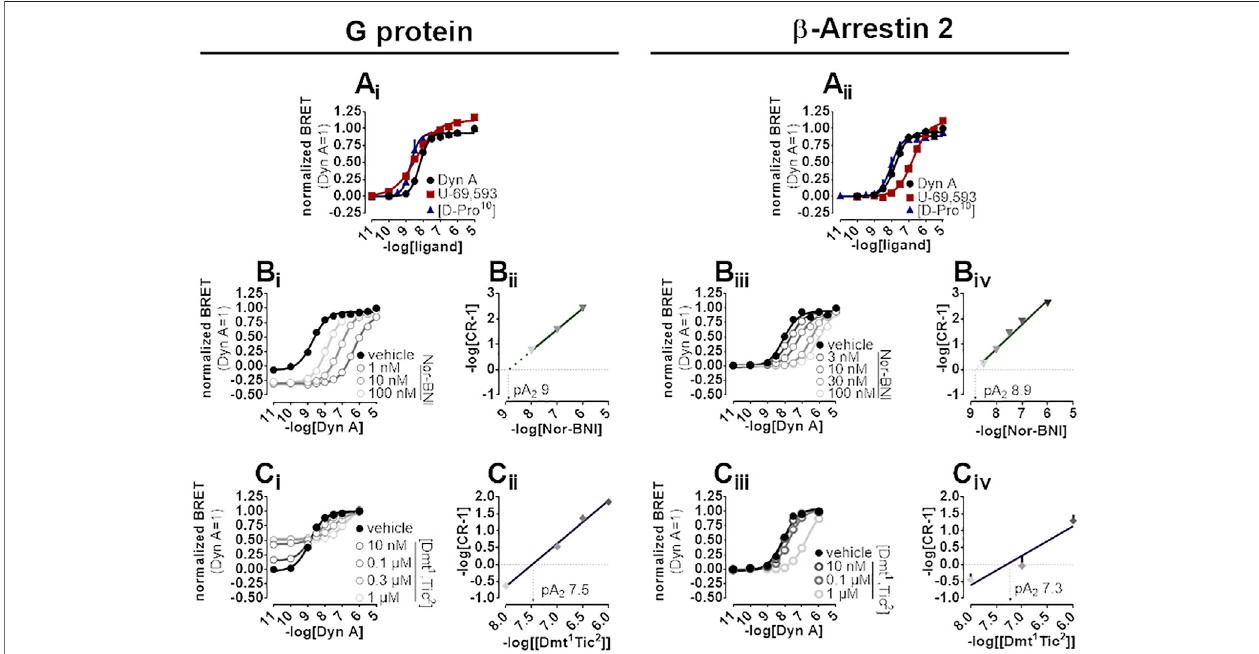
FIGURE 4 | BRET experiments in SH-SY5Y cells stably expressing the human kappa opioid-RLuc tagged receptor together with either the G β 1 -RGFP or the β - Arrestin 2-RGFP fusoprotein. Concentration-response curves to Dyn A, U-69,593, and [D-Pro 10 ] on the stimulation of kappa-G protein (A i ) and kappa- β -Arrestin 2 (A ii ) interaction. Concentration-response curves to Dyn A in the absence and in the presence of increasing concentrations of Nor-BNI on the stimulation of kappa-G protein (B i ) and kappa- β -Arrestin 2 (B iii ) interactions with corresponding Schild plots (B ii and B iv , respectively ) . Concentration-response curves to Dyn A in the absence and in the presence of increasing concentrations of [Dmt 1 ,Tic 2 ] on the stimulation of kappa-G protein (C i ) and kappa- β -Arrestin 2 (C iii ) interaction, with corresponding Schild analysis (C ii and C iv , respectively ) . Data represented are mean +sem of three to fi ve independent experiments performed in duplicate.